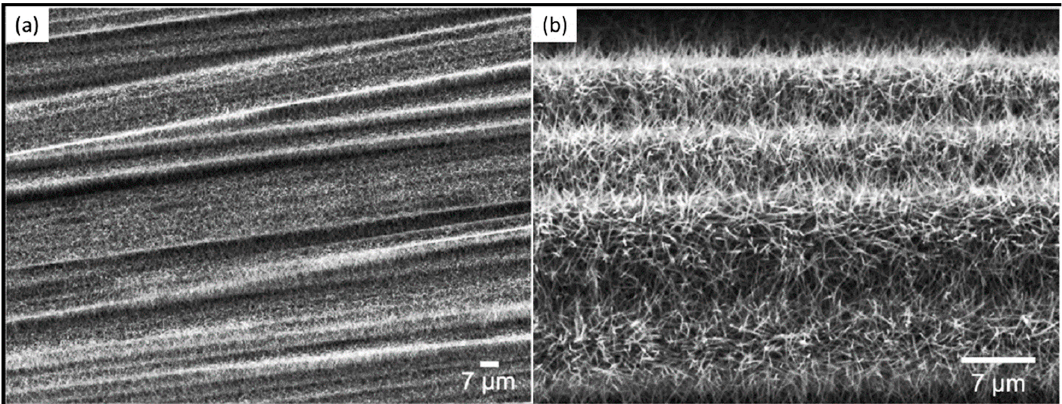
Figure 23. ( a ) CVD grown radially aligned CNT growths across CF yarn; ( b ) idem at higher magnification. Reprinted with permission from Li, Composites Science and Technology; Ref. [122] copyright 2015,